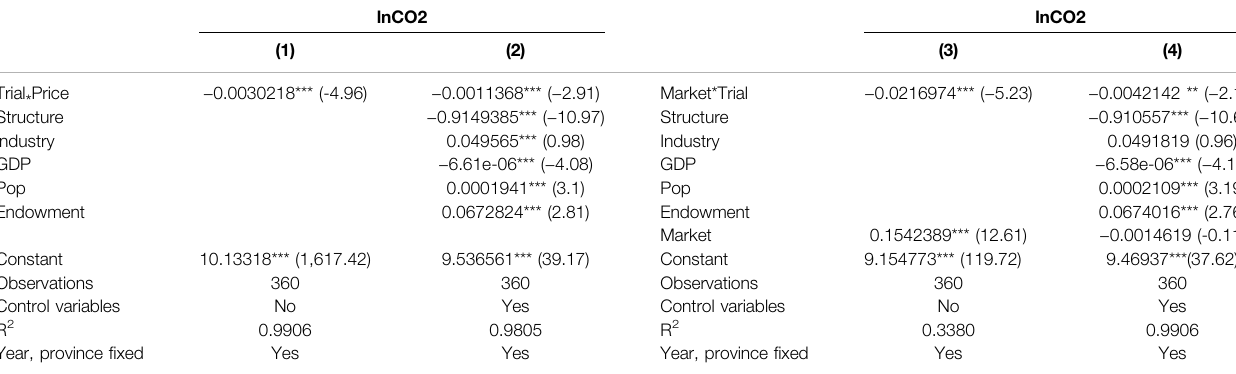
TABLE 7 | Impact of carbon price and marketization on carbon reduction effect of the carbon